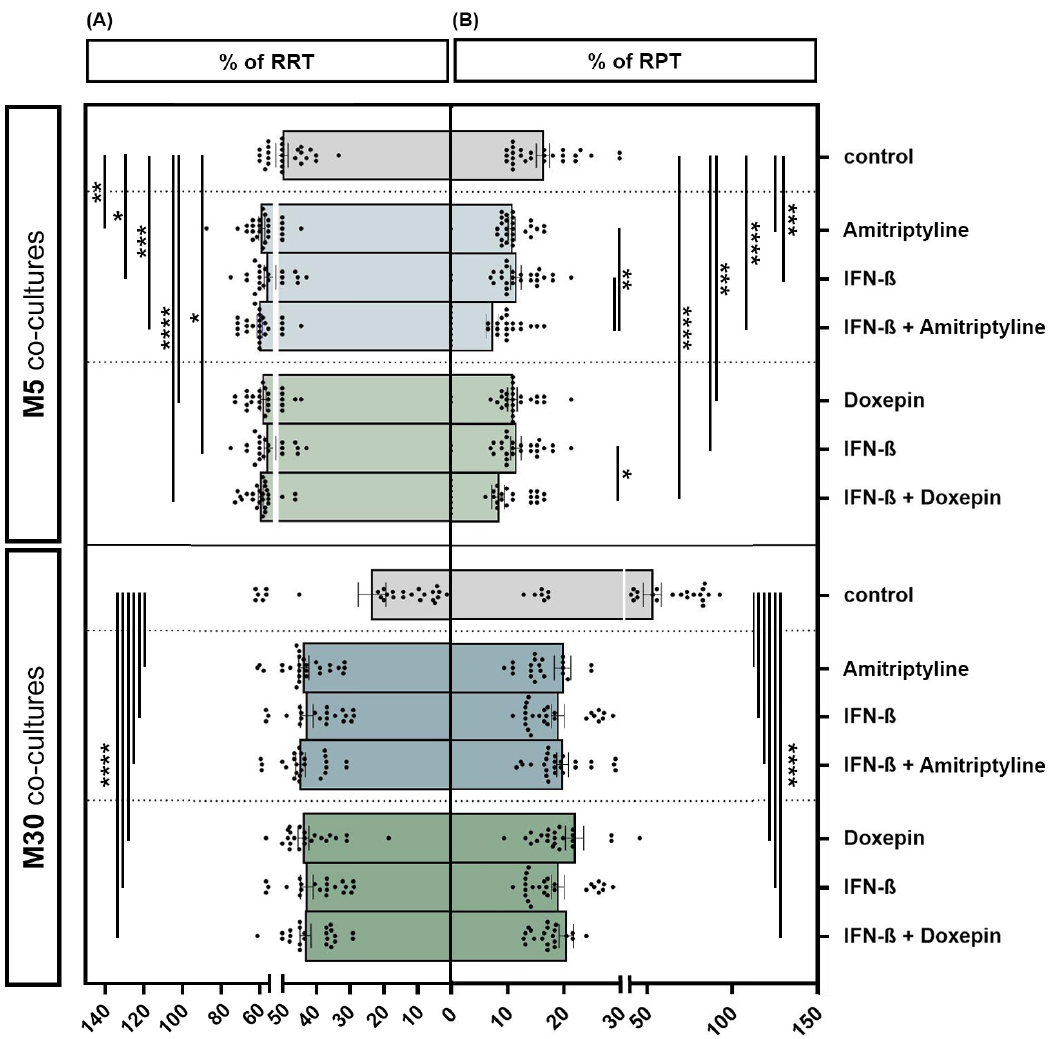
Figure 4. Microglial phenotypes after incubation with 10 ng/mL amitriptyline, 10 ng/mL doxepin and 2000 U/mL interferon- β (IFN- β ) under physiological (M5) and pathological conditions (M30). Incubation of the physiological M5 co-cultures with amitriptyline, doxepin or IFN- β led to a significant increase in resting ramified type of microglia (RRT) ( A ) with a significant decrease in the activated phenotype (RPT) ( B ) compared to the control. Pre-incubation with IFN- β and subsequent amitripty- line or doxepin addition also resulted in a significant decrease in activated microglia compared to incubation with one of the drugs alone ( n = 27). In the pathological M30 co-cultures, treatment with amitriptyline, doxepin or IFN- β alone led to a significant increase in resting ramified type of microglia (RRT) ( A ) with a parallel significant decrease in the activated phenotype (RPT) ( B ) compared to the control ( n = 27). Treatment of IFN- β pre-incubated pathological M30 co-cultures with amitriptyline or doxepin resulted in a significant increase in resting ramified microglial type (RRT) ( A ) with a parallel significant decrease in the activated phenotype (RPT) ( B ) compared to the control ( n = 27). Untreated co-cultures were used as controls. The individual experimental conditions were compared by two tailed t -tests. Differences were considered significant at p < 0.05: *, p < 0.01: **, p < 0.001: ***, p ≤ 0.0001: